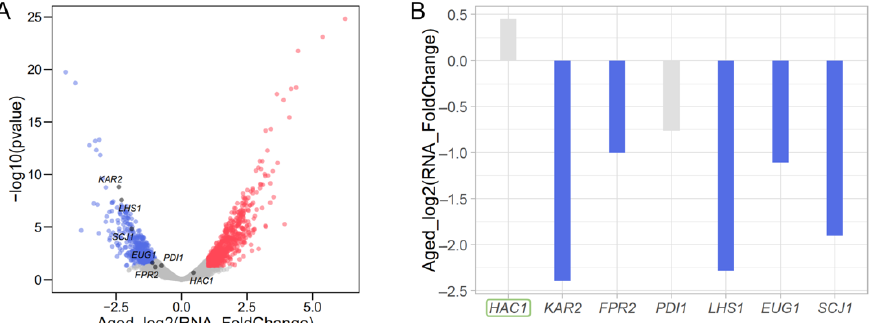
Figure 6. Changes in transcription levels of HAC1 and its downstream genes. Volcano plot ( A ) and bar plot ( B ) of changes in Aged cells are shown. Red and blue indicate upregulated and downregulated genes, respectively. Young cells were used as a control. Upregulated (red) and downregulated (blue) expression changes of more than twofold compared to Young cells are shown. Grey indicates no notable changes. HAC1 is indicated by the green box.